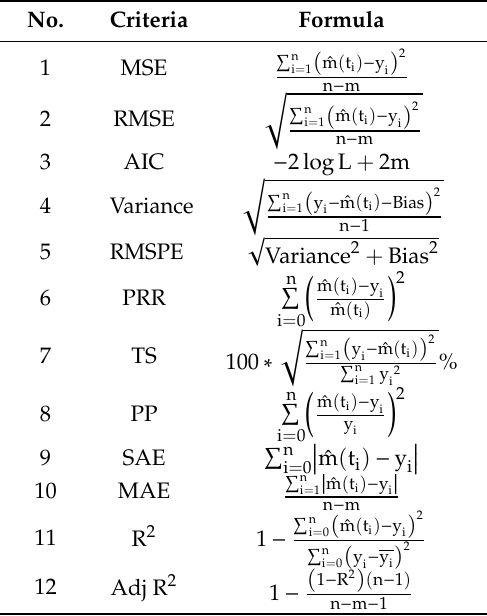
Table A1. List of criteria for model